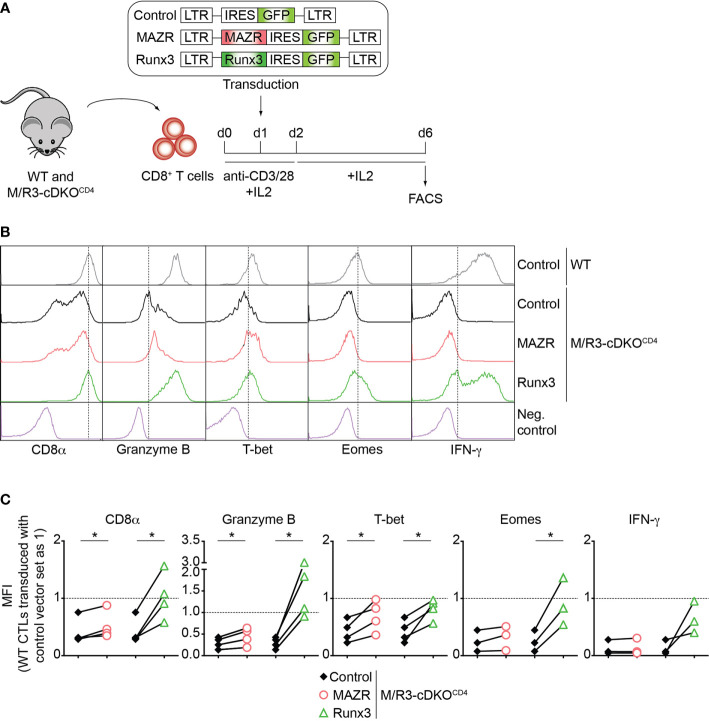
Enforced expression of MAZR partially restores impaired CTL differentiation in the absence of MAZR and Runx3. (A) Schematic figure showing the retroviral vector-mediated gene transduction of MAZR or Runx3 into WT and M/R3-cDKOCD4 CTLs. See the Methods section for the detailed experimental procedure. (B) Histograms showing CD8α, Granzyme B, T-bet, Eomes and IFN-γ expression in GFP+ WT CTLs transduced with a control vector as well as in GFP+ M/R3-cDKOCD4 CTLs transduced with control, MAZR- and Runx3-expressing vectors (6 days after in vitro anti-CD3/28 stimulation). T helper 2 (Th2) cells were included as negative controls for CD8α, Granzyme B, T-bet and Eomes stainings, whereas WT CTLs without restimulation were used as a negative control for IFN-γ staining. Vertical dotted lines indicate the peak of CD8α expression in WT CTLs or populations expressing the respective proteins based on the negative controls. (C) Diagrams showing the relative mean fluorescence intensity (MFI) of CD8α, Granzyme B, T-bet, Eomes and IFN-γ expression in GFP+ M/R3-cDKOCD4 CTLs transduced with control, MAZR- and Runx3-expressing vectors. The MFI values of GFP+ WT CTLs transduced with control vector were set as 1, and are indicated as horizontal dotted lines. Each dot represents value from each experiment, and paired experiments are indicated with lines. A paired two-tailed Student’s t-test was performed for statistical analysis. The p-values were defined as following: *p < 0.05. Data are representative (B) or show the summary (C) of 3-4 independent experiments.